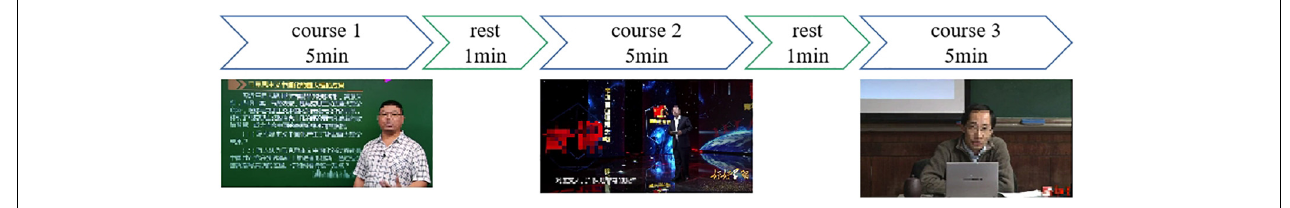
FIGURE 1 | Schematic of the visual attention experiment.